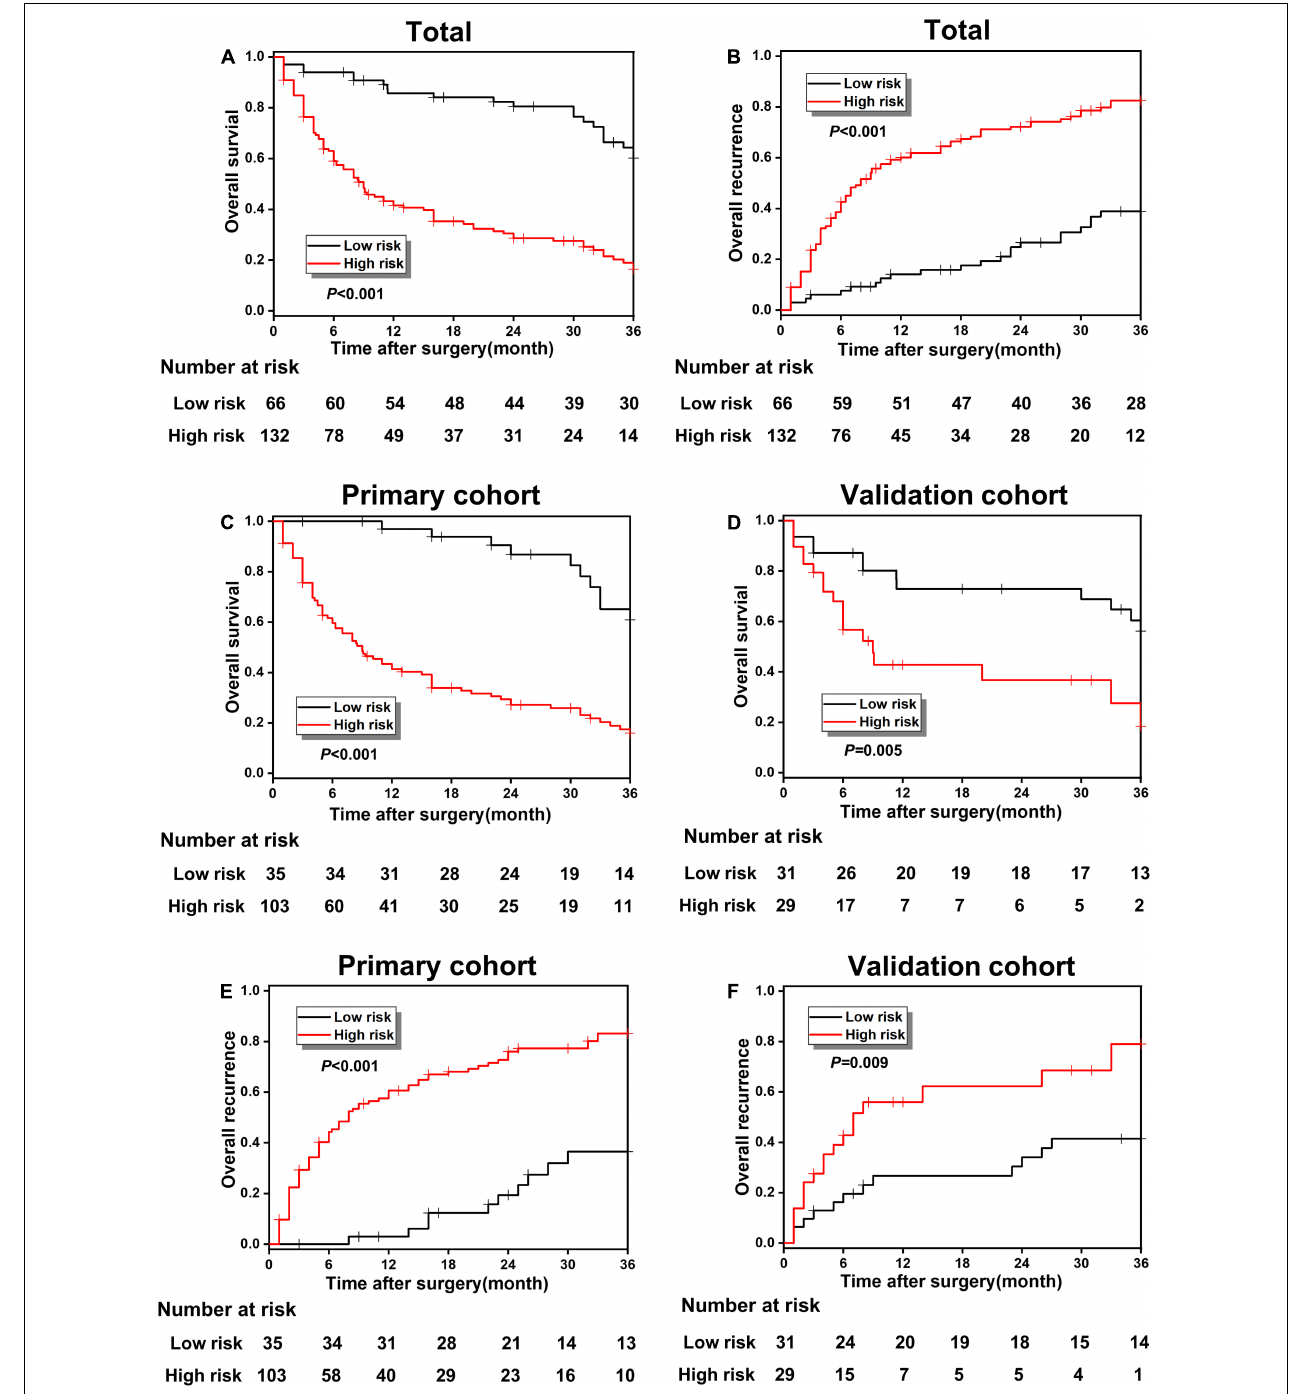
FIGURE 4 | (A,B) The overall survival (OS) and recurrence comparison in the whole cohort between poor prognosis low-risk and high-risk groups; (B–F) the OS and recurrence comparison in the primary and validation cohort between the low-risk and high-risk groups.